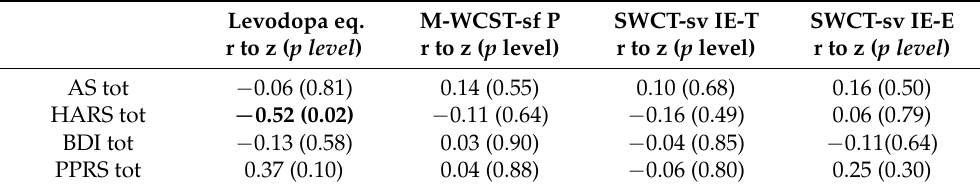
Table 2. Correlations in Parkinson’s Disease patients, between neuropsychiatric tests scores, dopamine replacement therapy and response inhibition tests